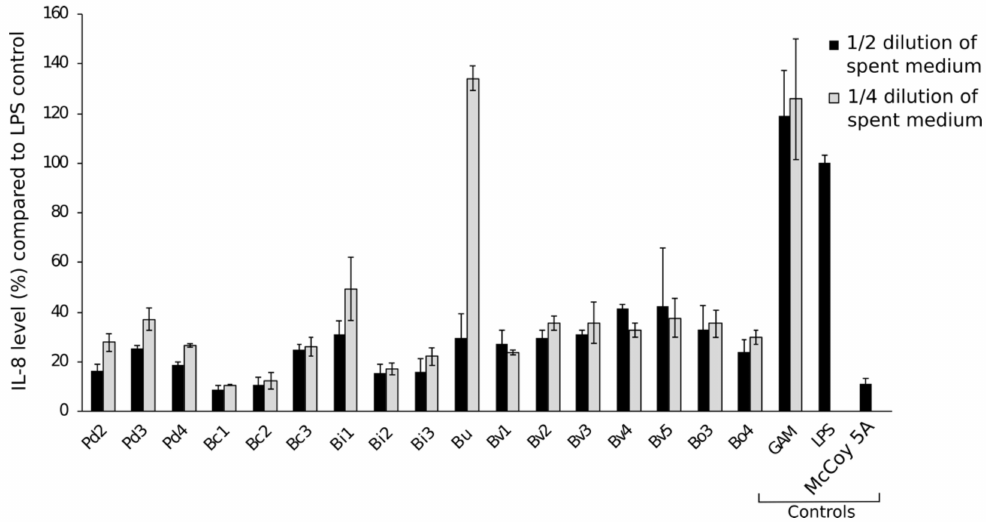
Figure 4. The attenuation capacity of the isolates using spent medium i.e., culture supernatant. Gifu anaerobic medium (GAM) and McCoy 5A media as well as only LPS were used as controls. LPS control represents 100% IL-8 release from HT-29 cells. 1 the assay. Pd = P. distasonis , Bc = B. caccae , Bf = B. fragilis , Bi = B. intestinalis , Bu = B. uniformis , Bv = B. vulgatus , Bo = B. ovatus . Numbers 1–9 refers to certain